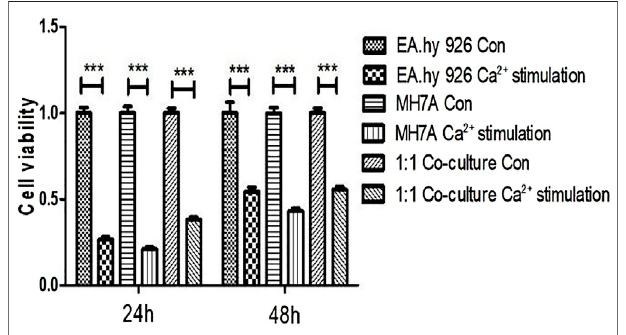
FIGURE2| CytotoxicityofcalciumonEA.hy926andMH7Aand1:1co- culture mixture in 2D planar. Cells were treated with CaCl2 solution for 5 min and washed with physiologic saline once. After 24 and 48 h, their viability was determinedusingCCK-8 assay(mean ± SD,* p < 0.05;** p < 0.01;*** p < 0.001, t-test). Con (cid:2) no calcium stimulation; SD (cid:2) standard